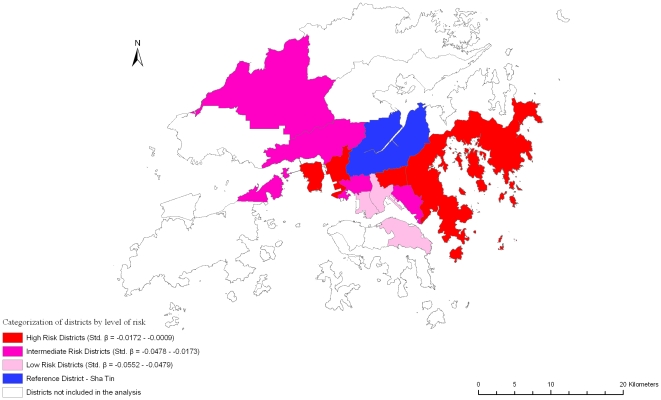
Risk variation in mortality across districts.